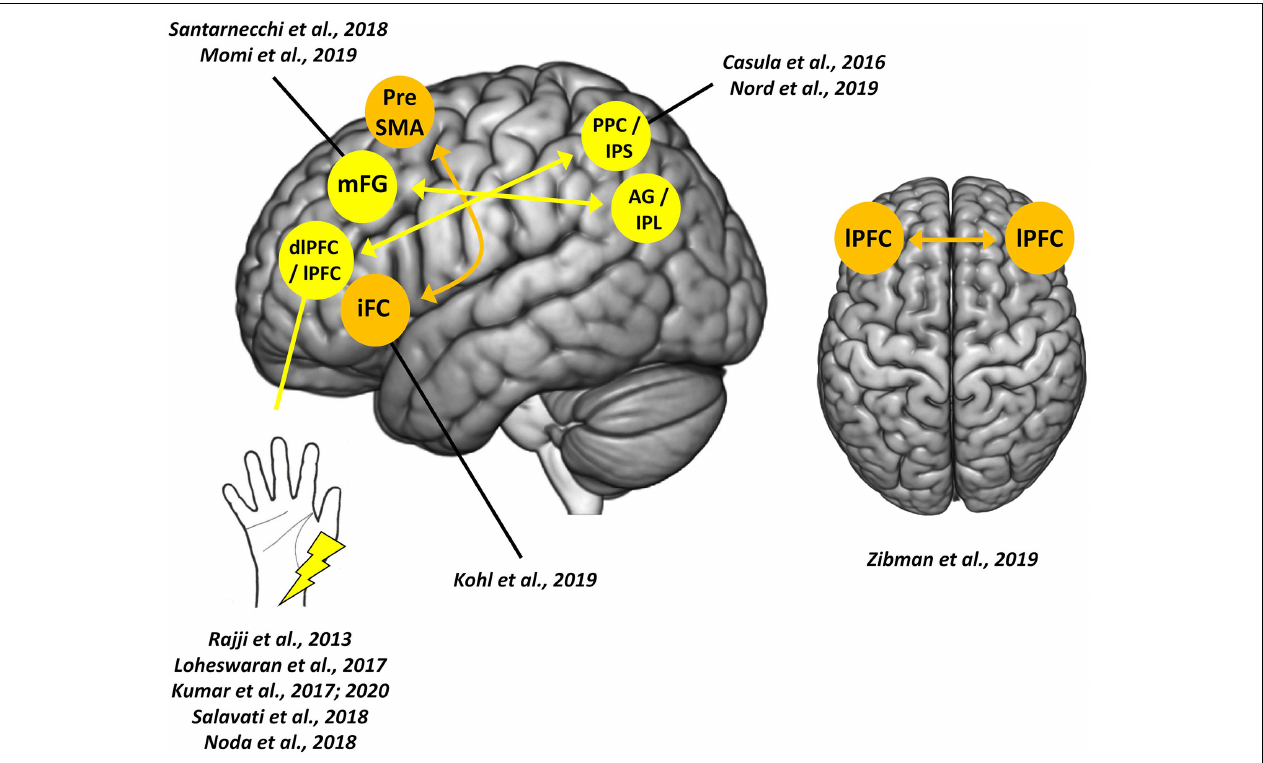
FIGURE 1 | Paired associative stimulation (PAS) targeting frontal cortices. Colored circles indicate sites of cortical stimulations; arrows indicate the direction of the cortico-cortical connection tested. The left hemisphere is depicted only for visualization purposes and does not reflect the hemisphere stimulated in the single study or by the single